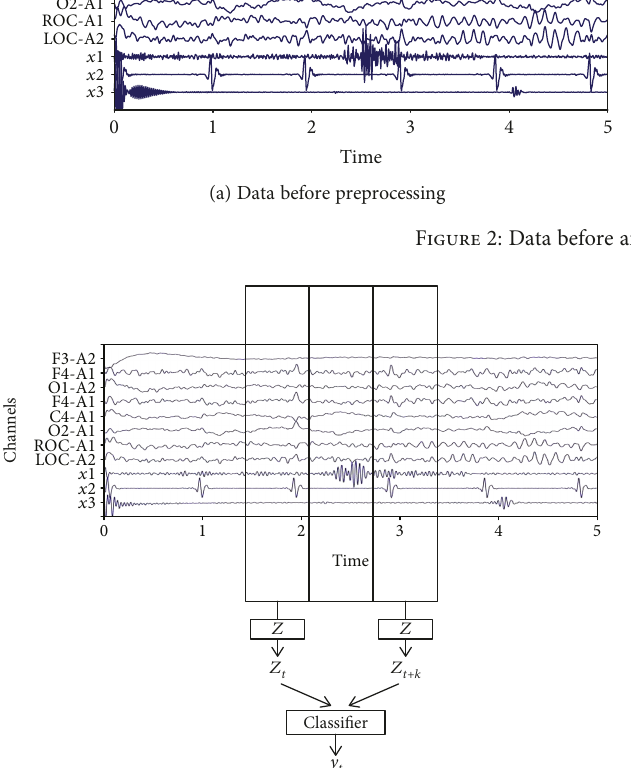
Figure 3: Time distribution of CNN with fi ne-grained